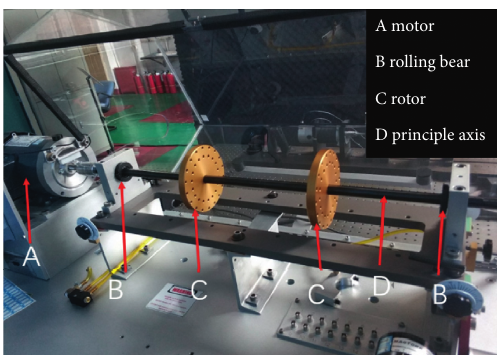
Figure 10: Mechanical fault comprehensive simulation test